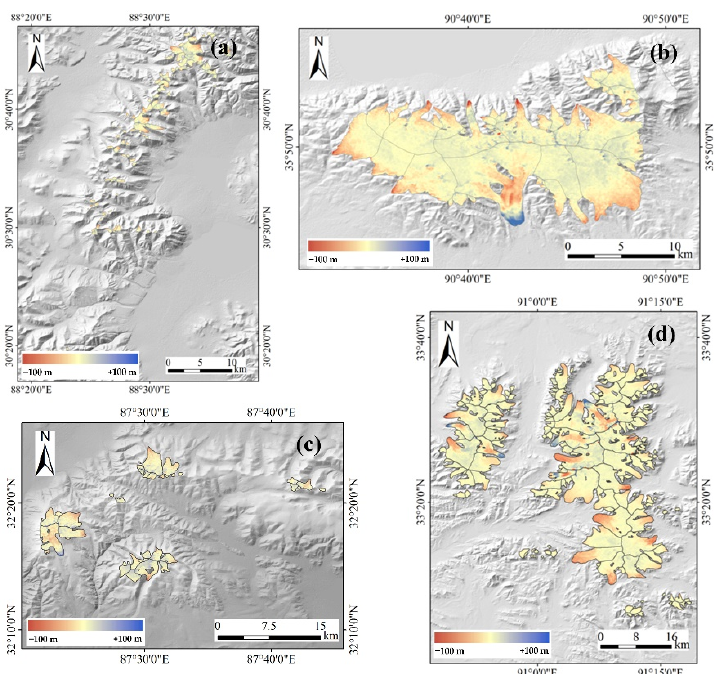
Figure 5. Same as Figure 3 but for the study sites of western Kunlun Mts. ( a ), Tozekangri Mount ( b ), Unnamed-1 Mts. ( c ) and Unnamed-2 Mts. ( d ).